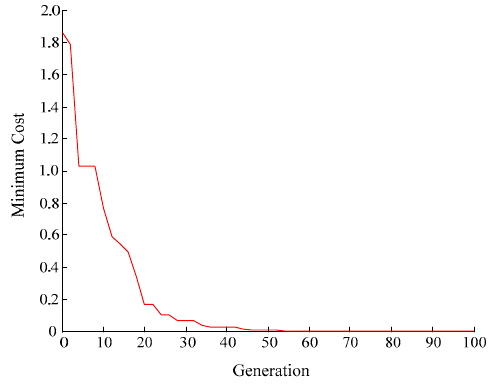
Figure 15. Optimum objective function convergence curve.